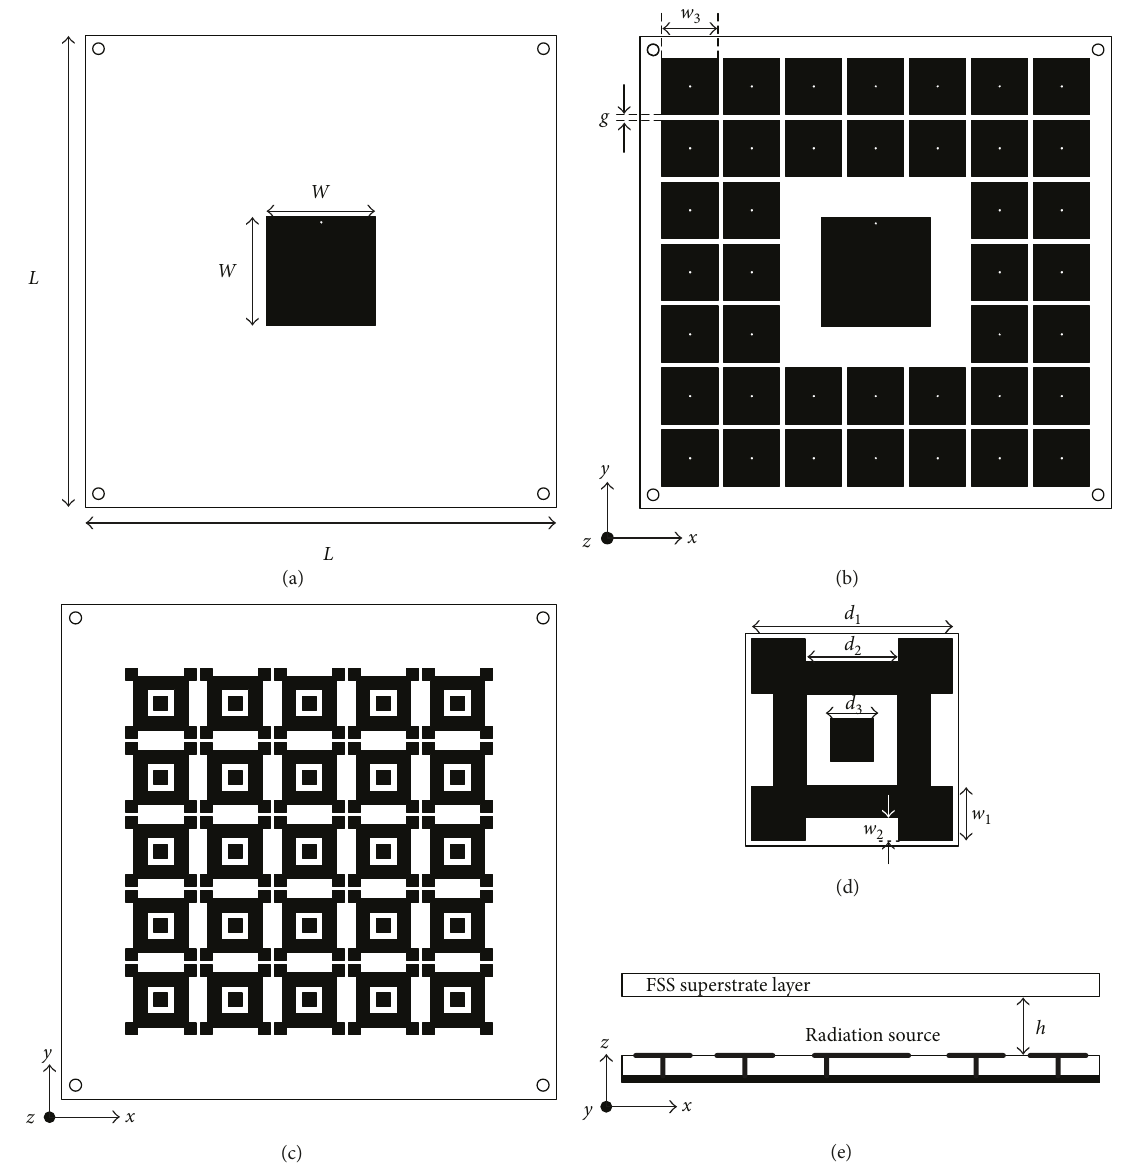
Figure 9: The antenna structure. (a) The initial antenna. (b) The antenna with HIS. (c) The modi fi ed FSS structure. (d) FSS unit cell. (e) Side view.